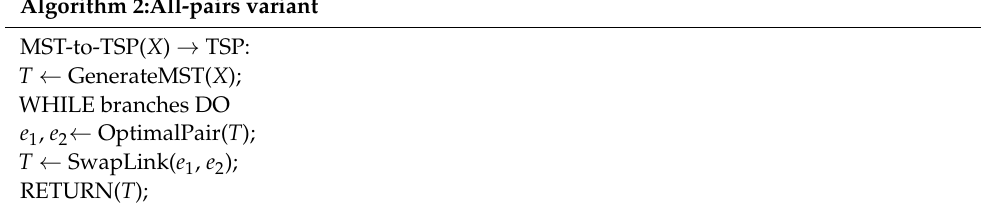
Algorithm 2:All-pairs